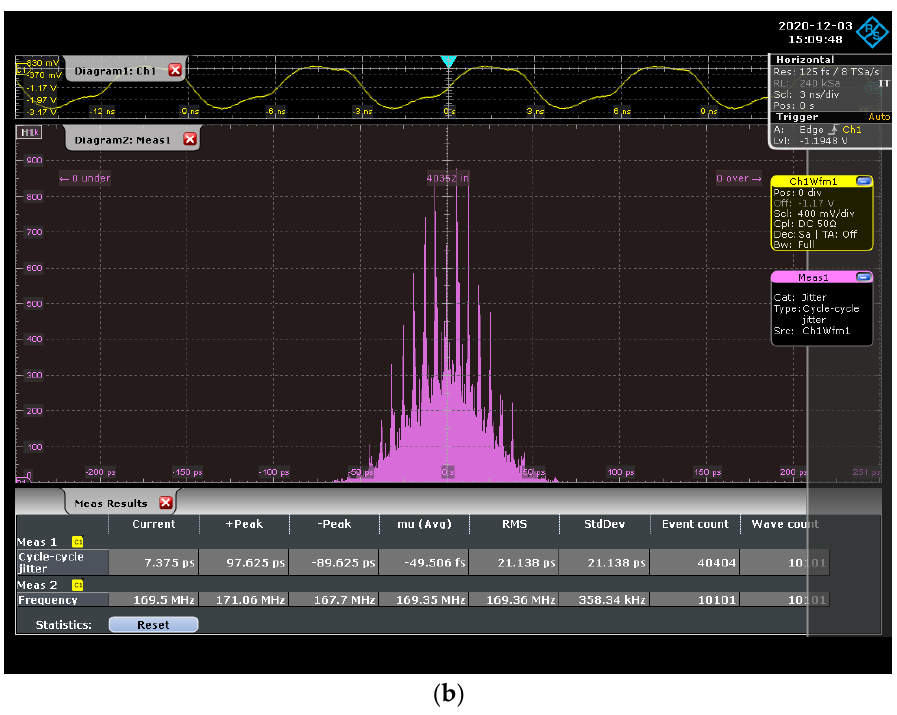
Figure 7. Chip measurement results of ( a ) at 364 MHz; ( b ) at 170 MHz.